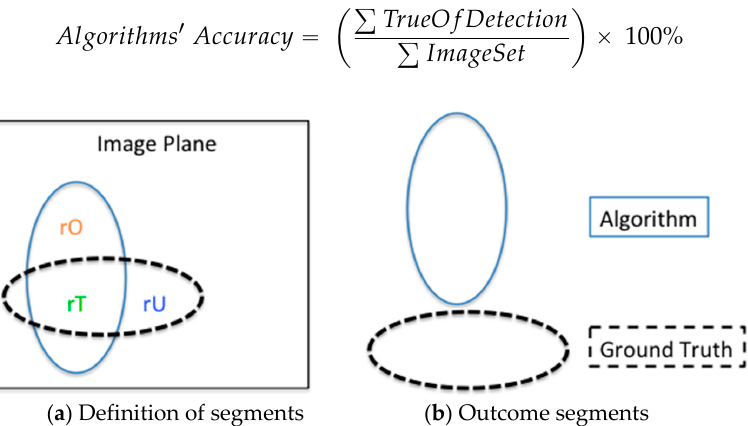
Figure 6. Accuracy determined according to the ground truth. ( a ) the resulting region pixels of the algorithm in the image plane are classified as: rT, matching the ground truth; rO, over-segmented; and rU, under-segmented. ( b ) the outcome segments produced with algorithm and ground truth.